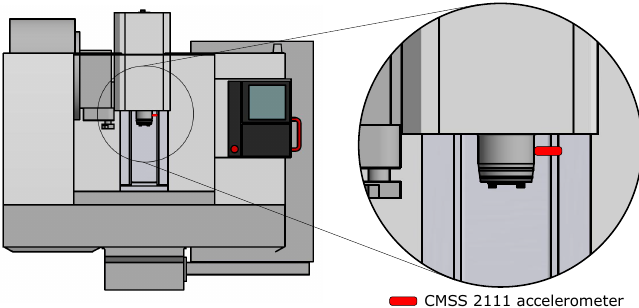
Figure 2. Placement of the CMSS 2111 accelerometer to the machine MCV 754.